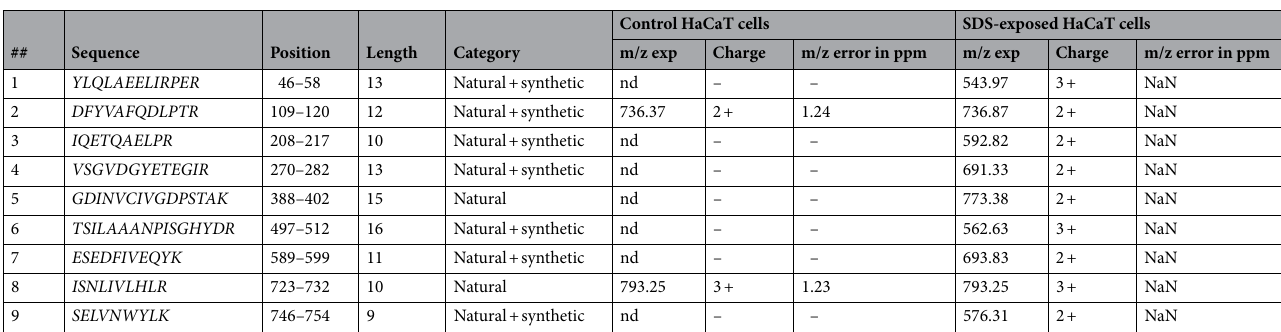
Table 2. The list of identified by SearchGUI peptides (sample preparation Protocol 1), which belong to DNA replication licensing factor MCM6 (MCM6_HUMAN, Q14566). NaN—m/z error in ppm equal